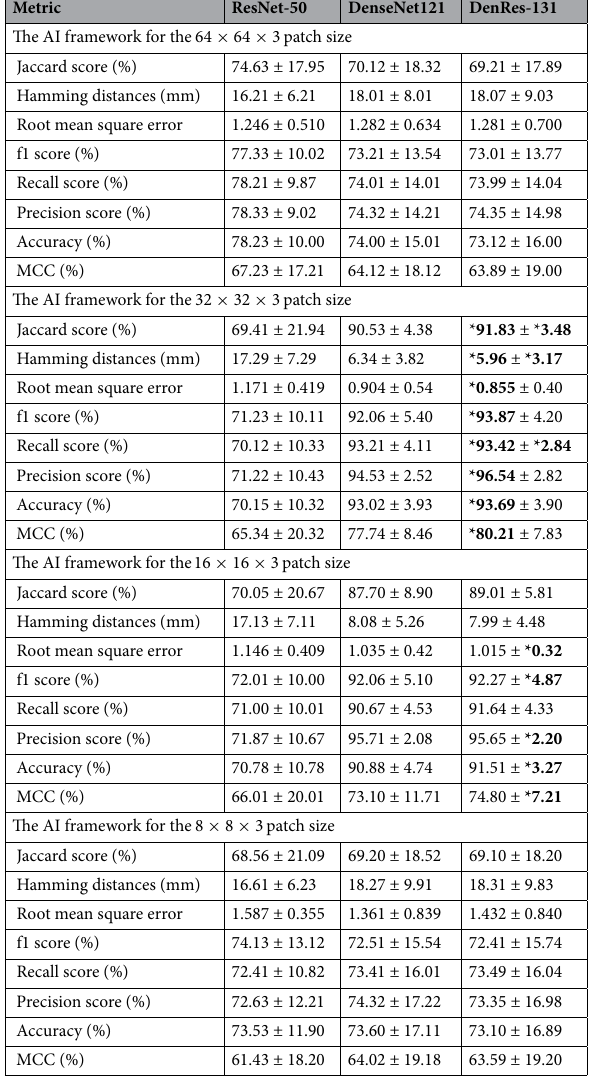
Table 1. Quantitative evaluation metrics of the AI framework on the unseen dataset. ∗ The highest performance of each metric score. Significant values are given in